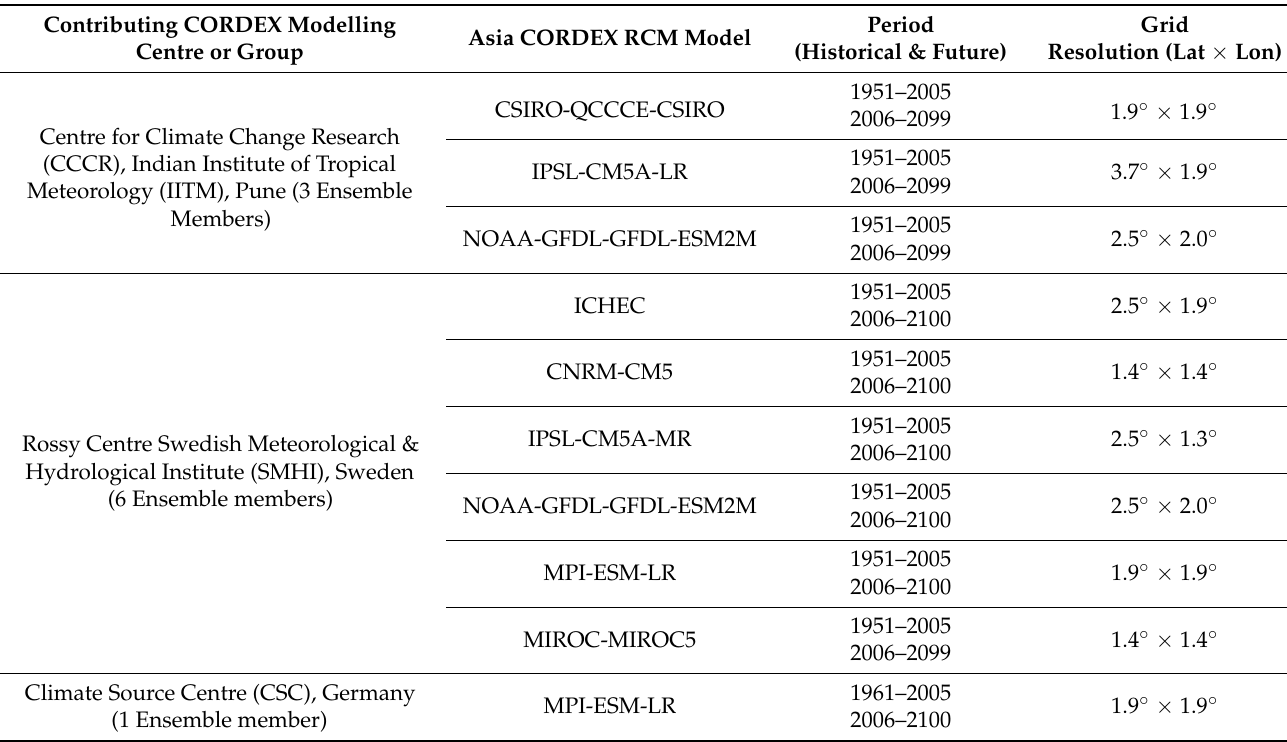
Table 1. List of CORDEX-SA RCMs used in this study with r1i1p1